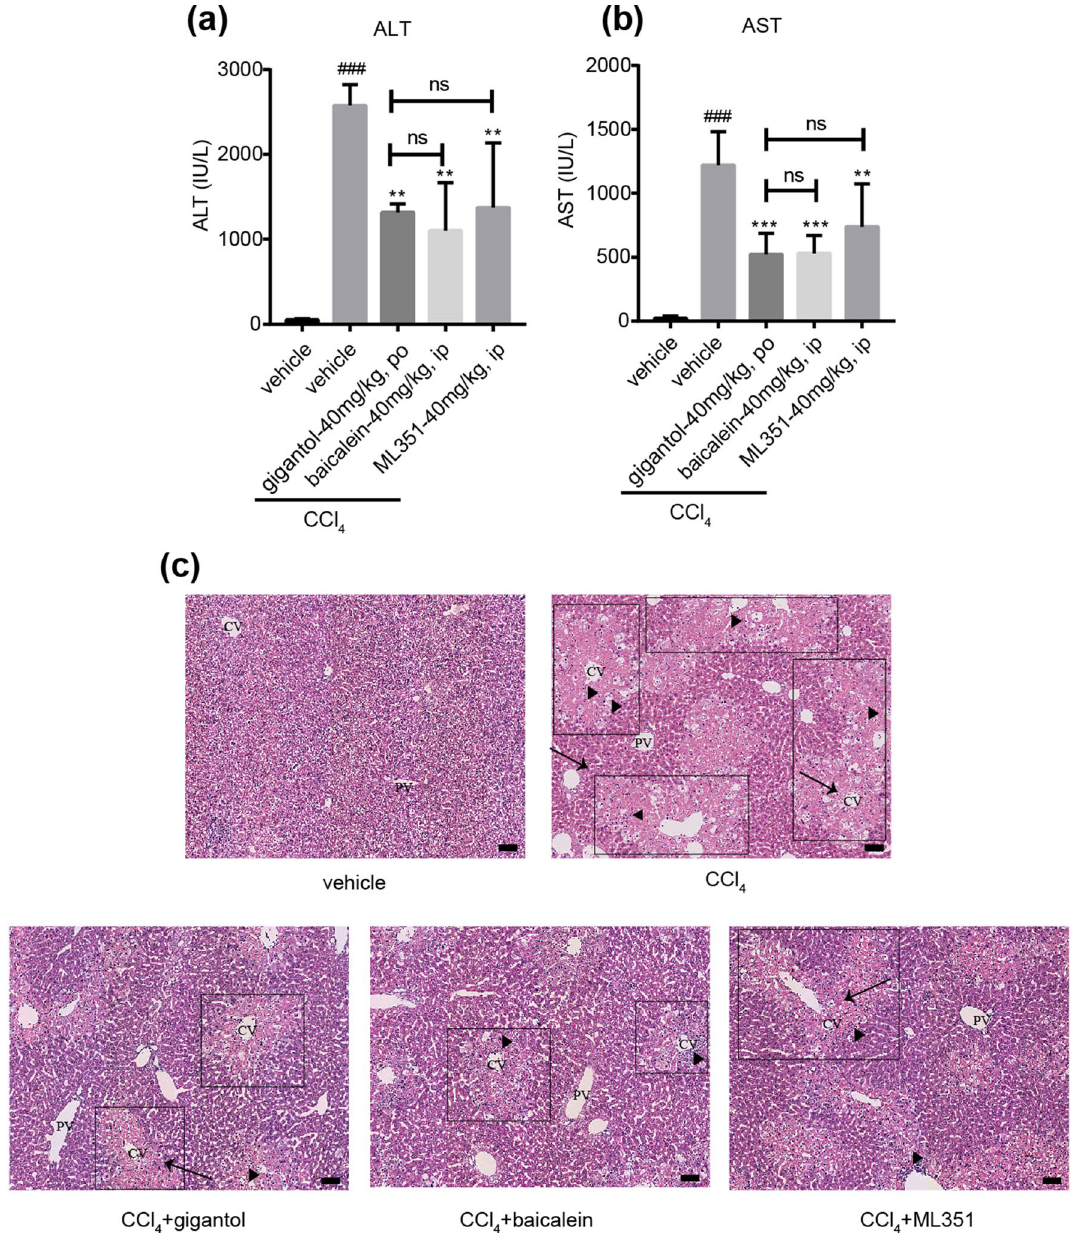
Figure 7. 12-LOX inhibitors ameliorates CCl 4 -induced liver injury to the same extent as gigantol. ( a ) Serum ALT and ( b ) AST levels in mice with or without gigantol (40 mg kg −1 d −1 , po , for 7 days), baicalein (40 mg kg −1 d −1 , ip , for 3 days) and ML351 (40 mg kg −1 , ip , 3 times within 24 h) pretreatment were measured at 16 h post CCl 4 injection. ( c ) Representative histological sections of liver tissues were stained with H&E. Symbols: black arrow-centrilobular necrosis; rectangle-tumefaction and steatosis; solid triangle-inflammatory infiltration. CV-centrilobular veins; PV-portal veins. The results are shown as the mean ± SD, n = 6 in each group. ### P < 0.001 versus the vehicle group; ** *P < 0.001, **P < 0.01 versus the CCl 4 group; ns means